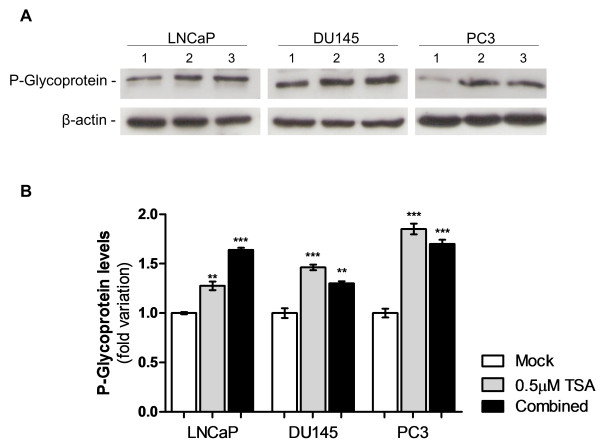
Effect of epigenetic drugs in P-glycoprotein expression in PCa cell lines after pharmacological treatment.(A) Protein gel blot analysis (1- Mock; 2–0.5 μM TSA; 3- 1μM DAC + 0.5 μM TSA). β-actin was used as loading control. (B) Relative levels of Pglycoprotein. Values of three independent experiments (average ± standard deviation) are represented as fold variation in comparison to Mock cells. Optical density of visible bands was determined and normalized with β-actin levels (**p < 0.01, ***p < 0.001; Oneway ANOVA, Dunnett’s Multiple Comparison Test).